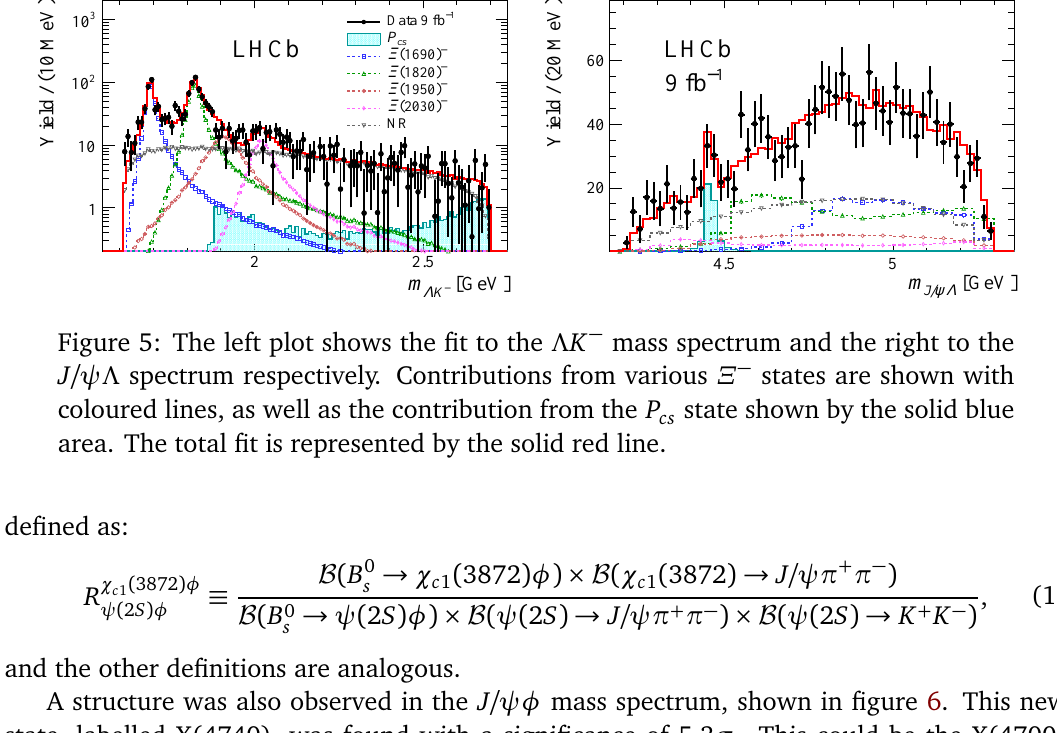
state shown by the solid blue cs